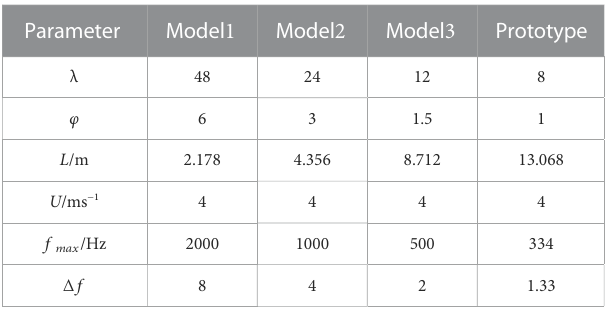
TABLE 3 Calculation parameters of different